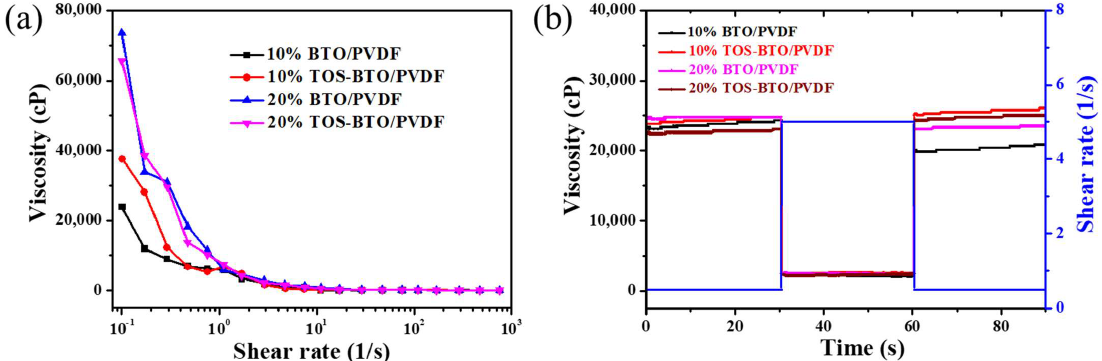
Figure 3. ( a ) Ink viscosity with shear rate and ( b ) thixotropic behavior for PVDF-based ink with various BTO and TOS-BTO nanoparticle contents.